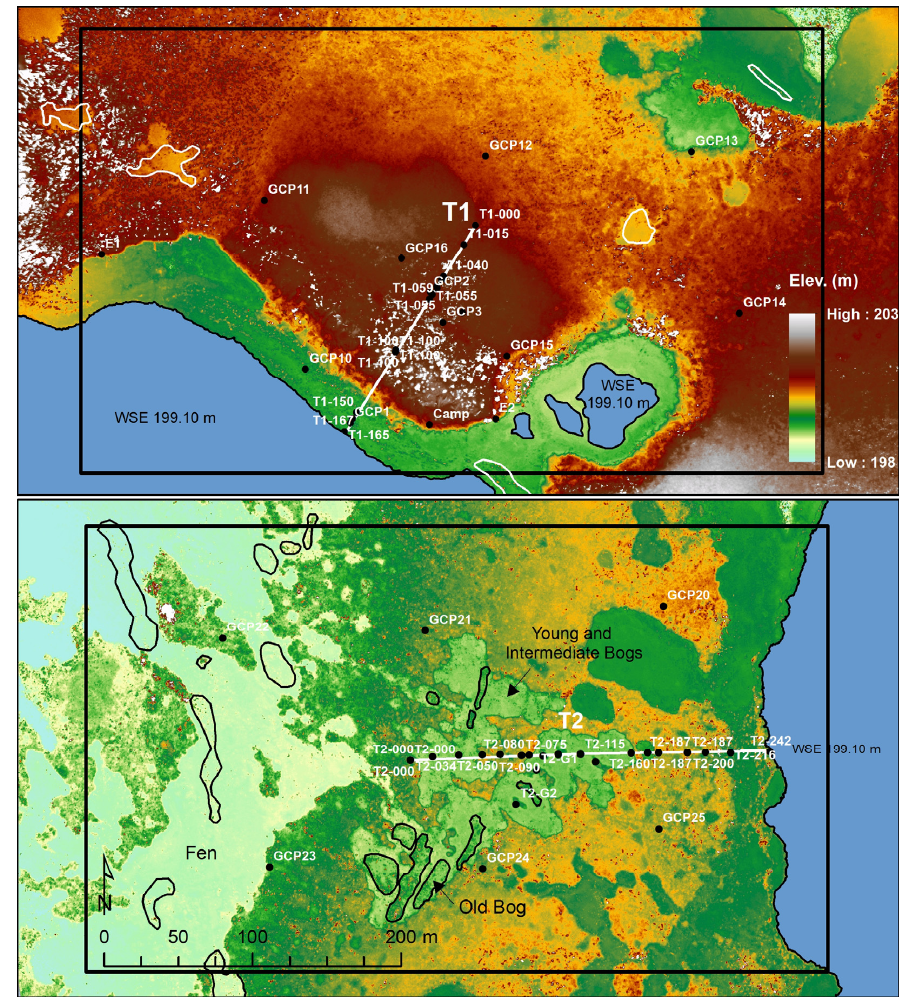
Figure 5. Surface topography (DEM) of Grid 1 on the high permafrost plateau ( top ) and Grid 2 on the low permafrost plateau ( bottom ) at Gosling Lake, central Alaska, in 2019. Water surface elevation (WSE) is based on transect survey. Old bogs are highlighted in white ( above ) or black polygons ( below ). Survey transects ( white lines ) and sampling locations ( black dots ) are also provided.